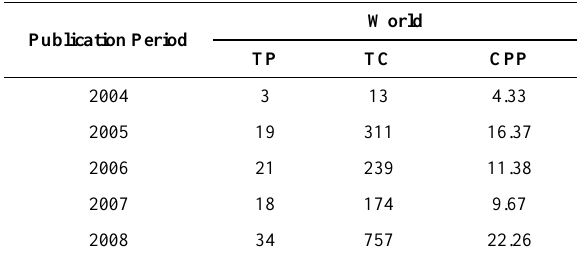
Table 1. Annual global publications output on deep learning,